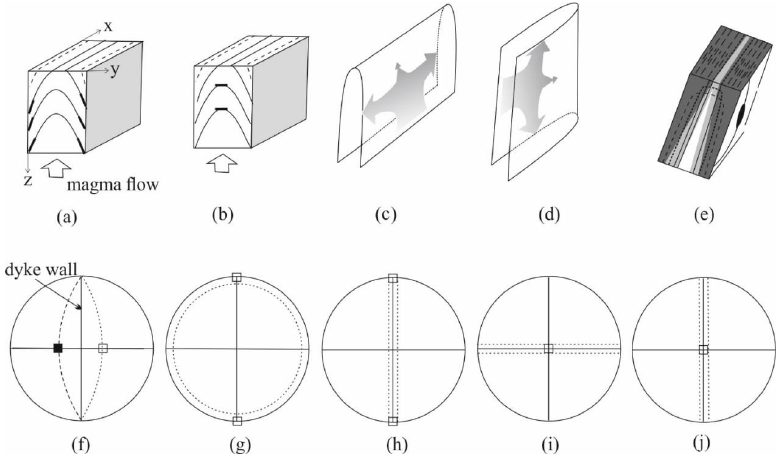
Figure 9. Schematic sketch of the magma flow and the AMS in the dyke without transcurrent movement of dyke walls. In a to d , the magma flow resembles the flow of the Newtonian liquid; in e , the magma movement resembles flow of the Binghamian liquid. a , b — vertical magma flow, c — change of vertical magma flow to horizontal flow, d — change from horizontal flow to vertical flow, f — orientations of magnetic foliation (great circles) and magnetic lineation (squares) in the marginal parts of the model a (dashed circles and close squares — left margin, dotted circles and open squares — right margin), g — magnetic foliation and lineation in the model b , h — magnetic foliation and lineation in the model c , i — magnetic foliation and lineation in the model d , j — magnetic foliation and lineation in the model e . Dyke coordinate system (x,y,z), equal-area projection on the lower hemisphere. Adapted from [5,7] using our own program for modeling magnetic particle orientations during flow and simple shear